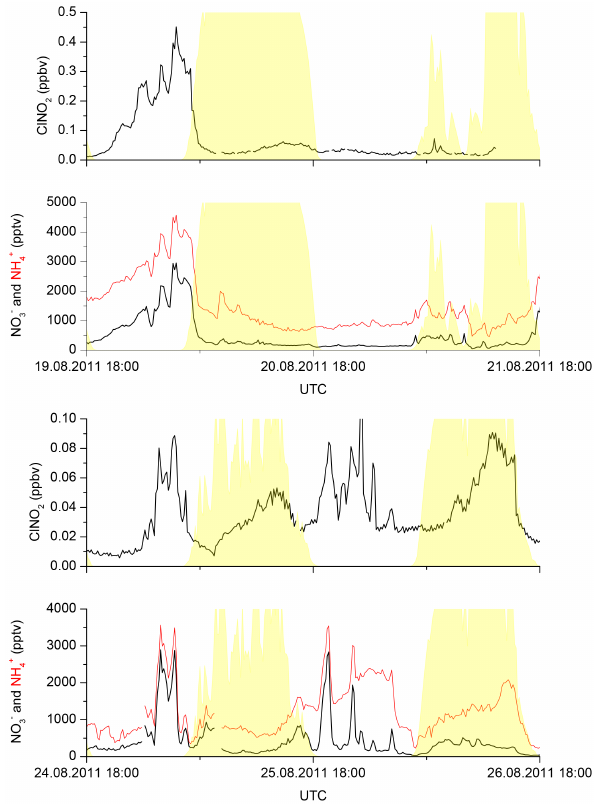
Figure 4. Zoomed-in graph of particle-nitrate and ClNO 2 formation over 4 nights. Global radiation (yellow) is plotted to separate day- to-night periods and indicate the day-to-day relative photochemical activity. Note that the ClNO 2 plotted for these days was measured at m/z = 161.9 and, therefore, contains a contribution from HCl, hence the apparent daytime production.